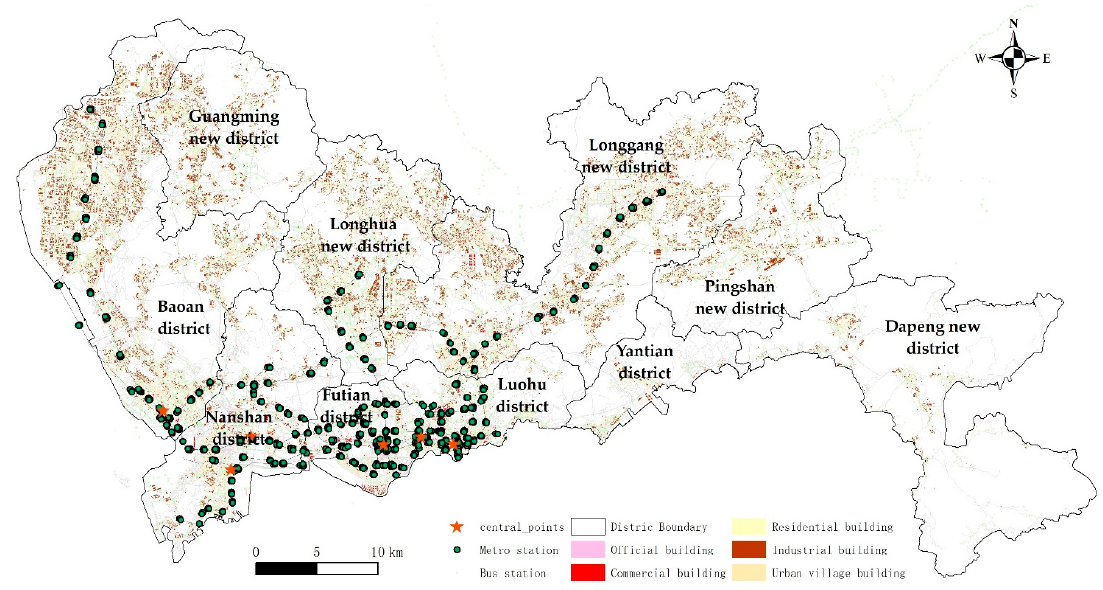
Figure 3. The transportation and building information in Shenzhen.